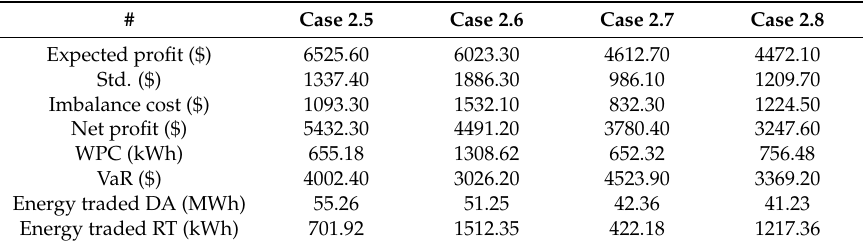
Table 5. Sensitivity analysis for risk aversion and uncertainty parameters.